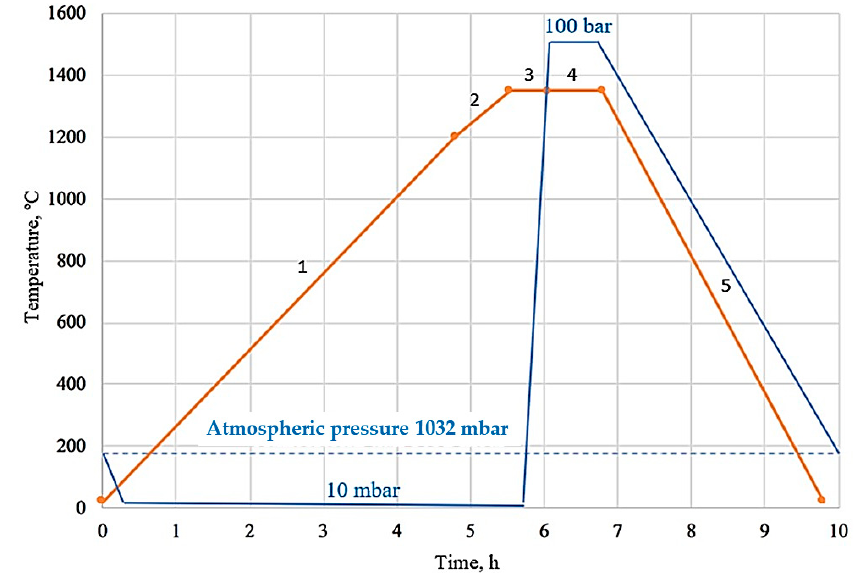
Figure 4. Scheme of sinter-HIP process: 1—Heating with rate of 5 K / min. up to 1200 ◦ C at 10 mbar Ar pressure; 2—Heating with rate of 10 K / min. from 1200 ◦ C to 1350 ◦ C at 10 mbar Ar pressure; 3—Holding at 1350 ◦ C for 30 min.; 4—Increasing of Ar pressure up to 100 bar and holding at 1350 ◦ C for 45 min.; and, 5—Reducing pressure, degassing Ar and cooling to the room